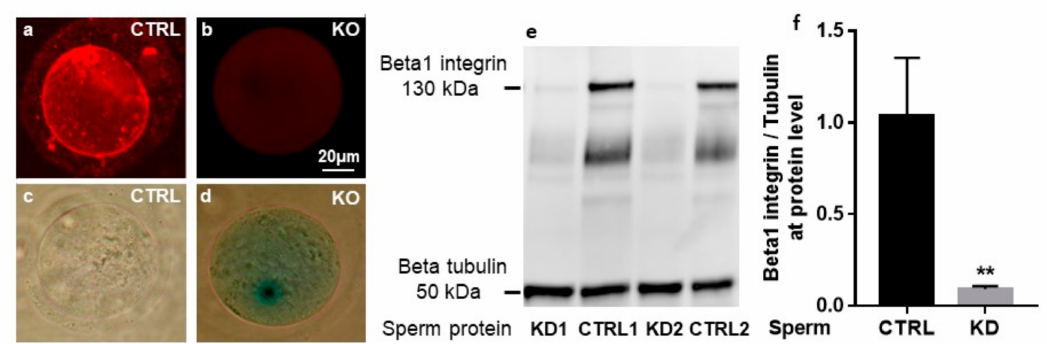
Figure 2. Analysis of the excision of the Itgb1 floxed gene in the oocytes and the sperm. Analysis of immunofluorescence staining of β 1 integrin in control oocytes (CTRL) ( a ) and knockout (KO) ( b ) oocytes using the anti- β 1 integrin monoclonal antibody (MB1.2). Analysis of β -galactosidase staining in CTRL ( c ) and KO ( d ) oocytes. ( e ) immunoblotting with anti- β 1 integrin and anti- β -tubulin antibodies was performed as described in Materials and Methods. The specific bands of β 1 integrin subunit and β -tubulin (130 kDa and 50 kDa, respectively) were detected on sperm extracts. Analysis showed decreased expression levels in KD sperm (lanes KD1 and KD2) when compared to CTRL sperm (CTRL1 and CTRL2) while the level of expression of β -tubulin was comparable in the four samples. ( f ) quantification of Western blot band intensities using ImageJ software. The detection of β -tubulin in each sample served as a loading control. The relative intensities of the protein signals were quantified by densitometry and normalized to the corresponding β -tubulin density. Data are expressed as percentage relative to CTRL. The bar graphs represent the mean ± s.e.m. of 3 samples in each group. ** p =